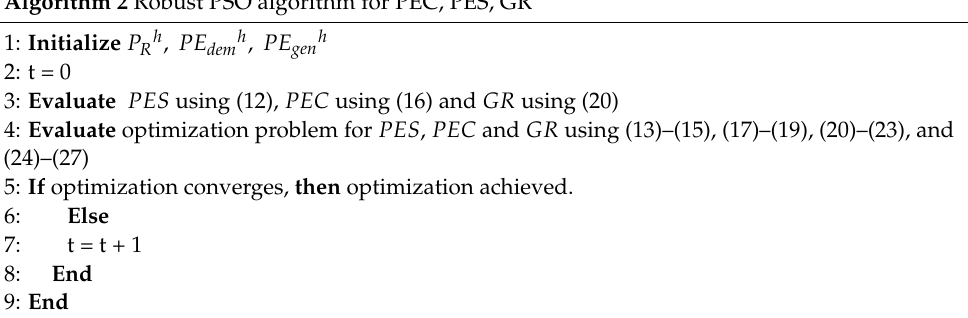
Algorithm 2 Robust PSO algorithm for PEC, PES,